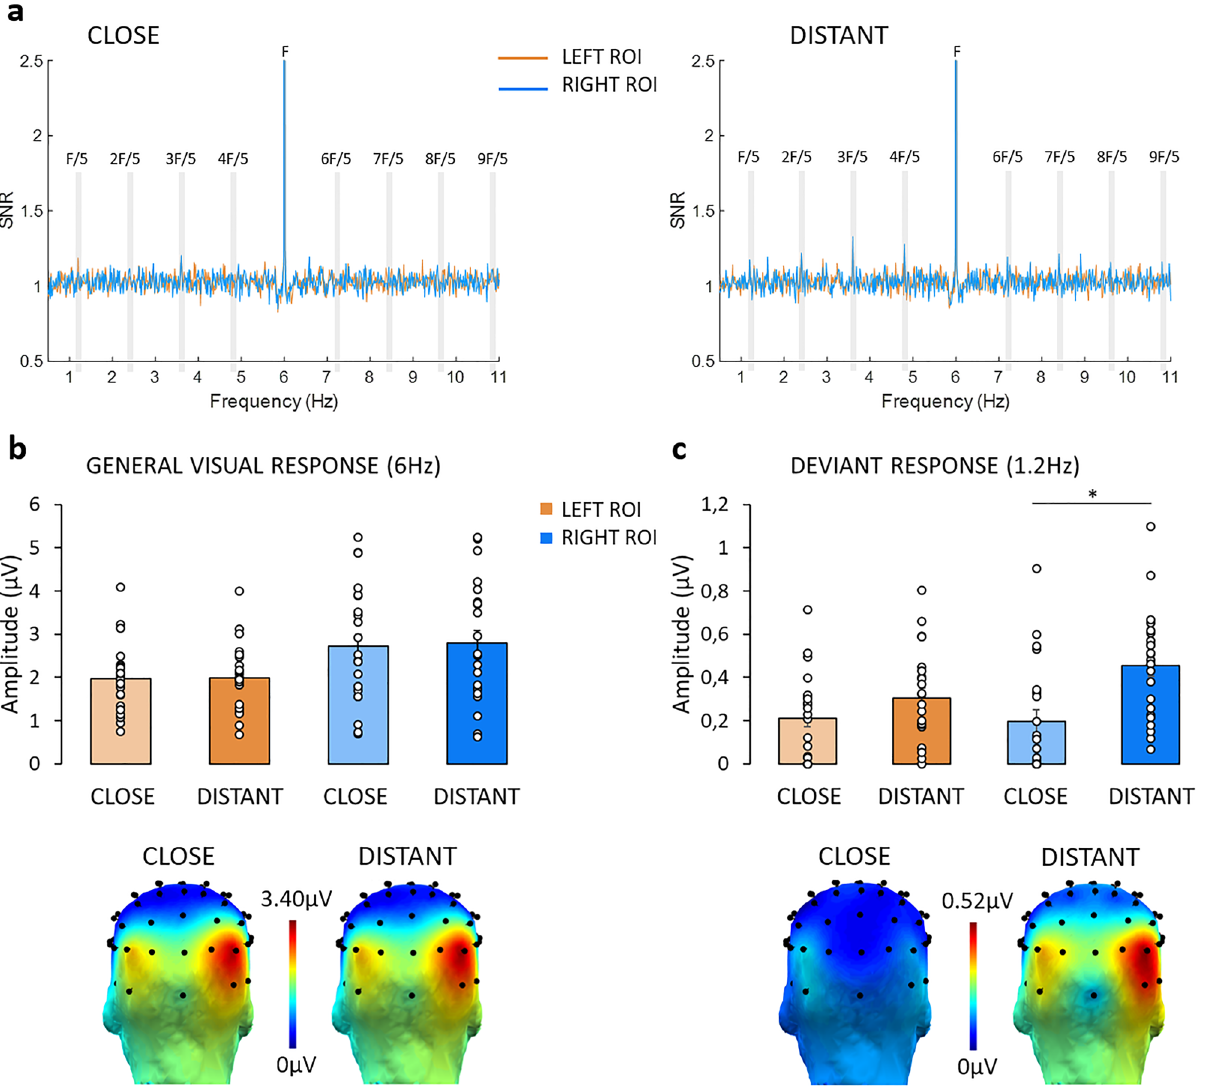
Figure 2. ( a ) Averaged SNR response spectra show the response peaks at the frequencies of interest in the left (orange) and right (blue) ROI, for the close (left panel) and the distant (right panel) conditions. F = 6 Hz for the general visual stimulation and F/5 = 1.2 Hz + harmonics (highlighted in grey) for the deviant stimulation. ( b ) General visual response amplitudes and topographies. Participant’s responses in the left and the right ROI for the close and distant conditions. Topographies display the sum of noise-corrected amplitudes for the significant harmonics (from 6 to 42 Hz). ( c ) Discrimination response amplitudes and topographies. Responses elicited by the presentation of the deviant number in the close and the distant conditions, in the left and right ROI. Topographies display the sum of noise-corrected amplitudes for the significant harmonics (from 1.2 to 10.8 Hz, excluding the 6-Hz frequency). Dots show individual data and bars represent standard errors of the mean. The asterisk (*) highlights a significant difference with p < 0.01 reflecting stronger discrimination responses for the distant condition in the right ROI